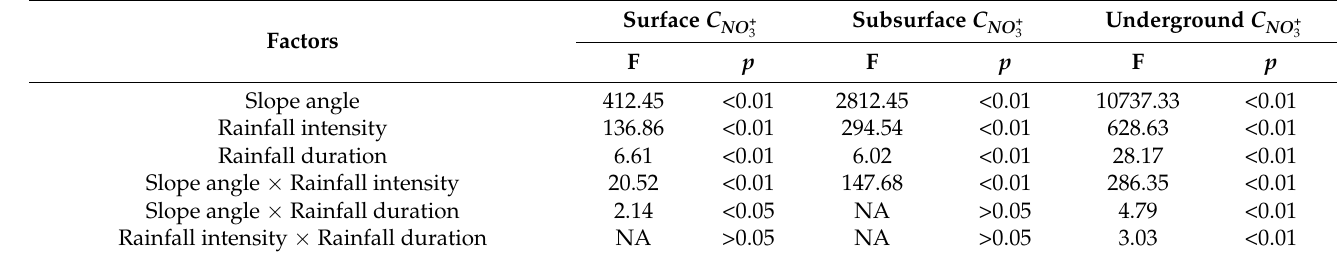
Table 7. Multivariate analysis of variance of nitrate-nitrogen concentration in runoff of Karst slope farmland with rainfall intensity, slope, and rainfall